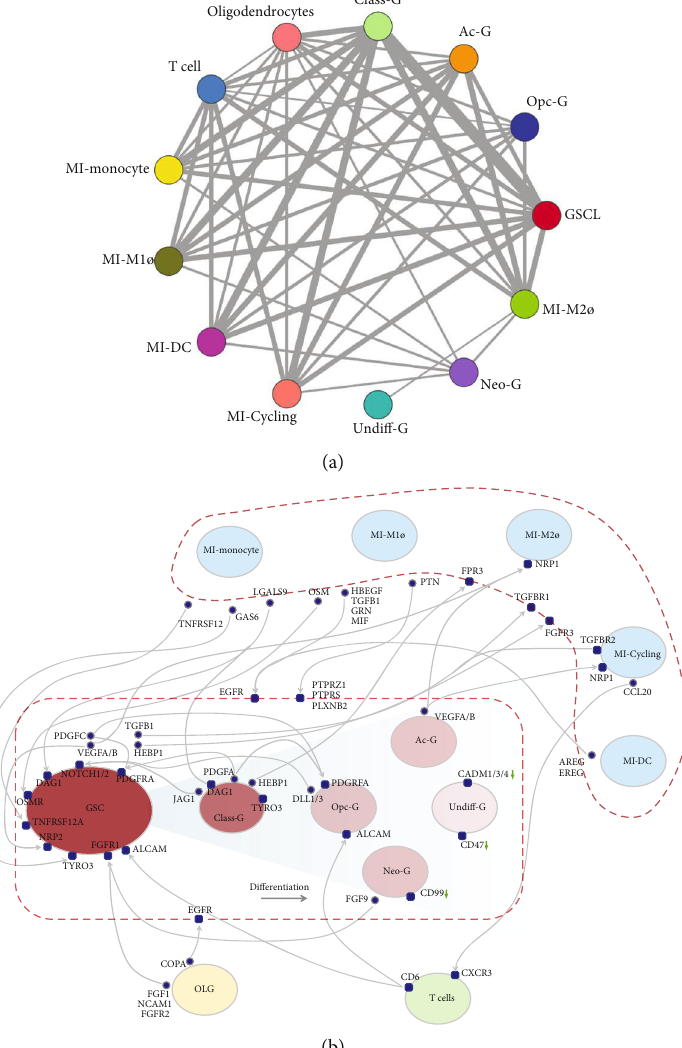
Figure 7: Ligand-receptor interactions between the clusters in GBM samples. (a) Cell-cell interaction networks estimated in GBM samples. (b) Schematic representation of di ff erences in the microenvironment among CSCL/Ac-G/Class-G/Opc-G/Neo-G/Undi ff -G cell clusters in GBM